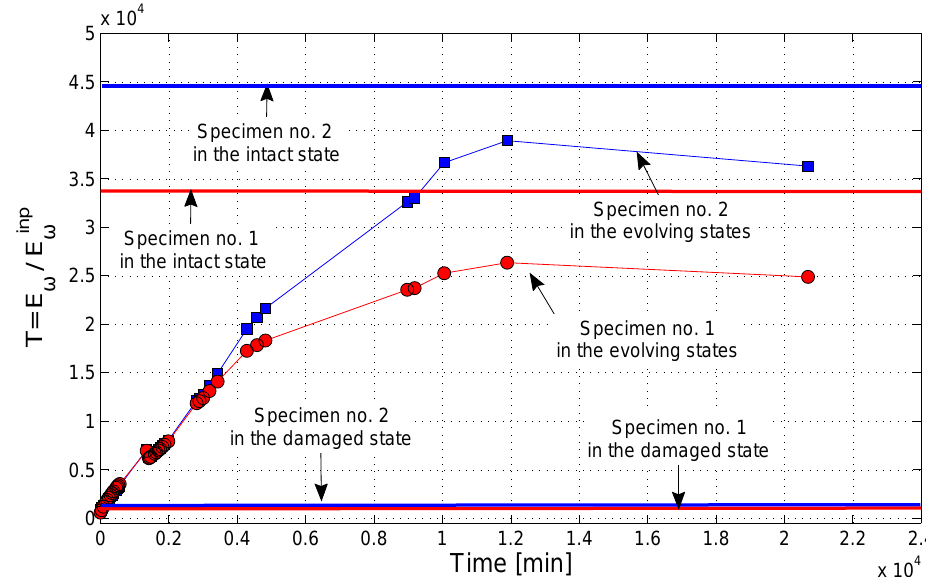
Figure 5. Evolution in time of the transmission coefficient T at the fundamental frequency for Specimen No. 1 and Specimen No.